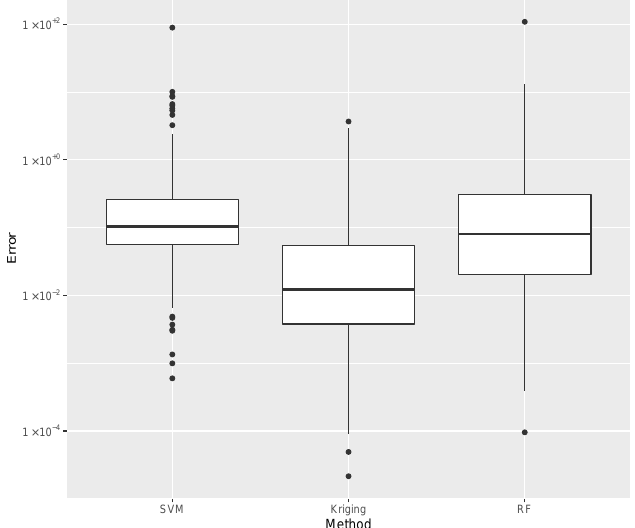
Figure 15. Comparison of mass error dispersion considering the best SVM, Kriging, and Random Forest estimates.